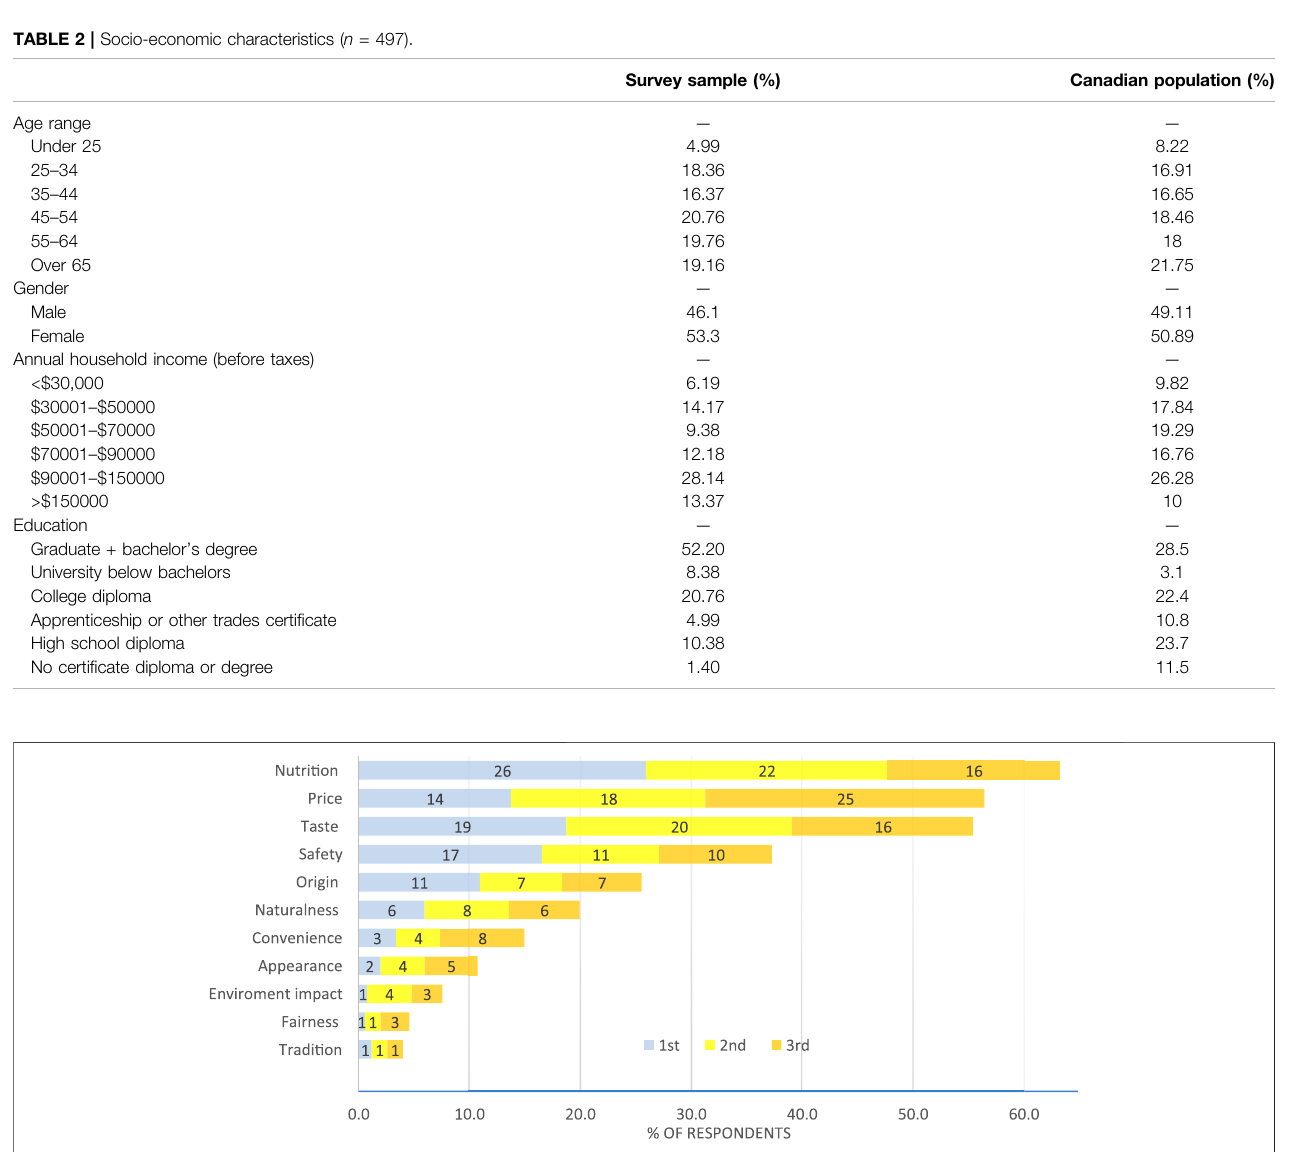
Frontiers in Genome Editing |